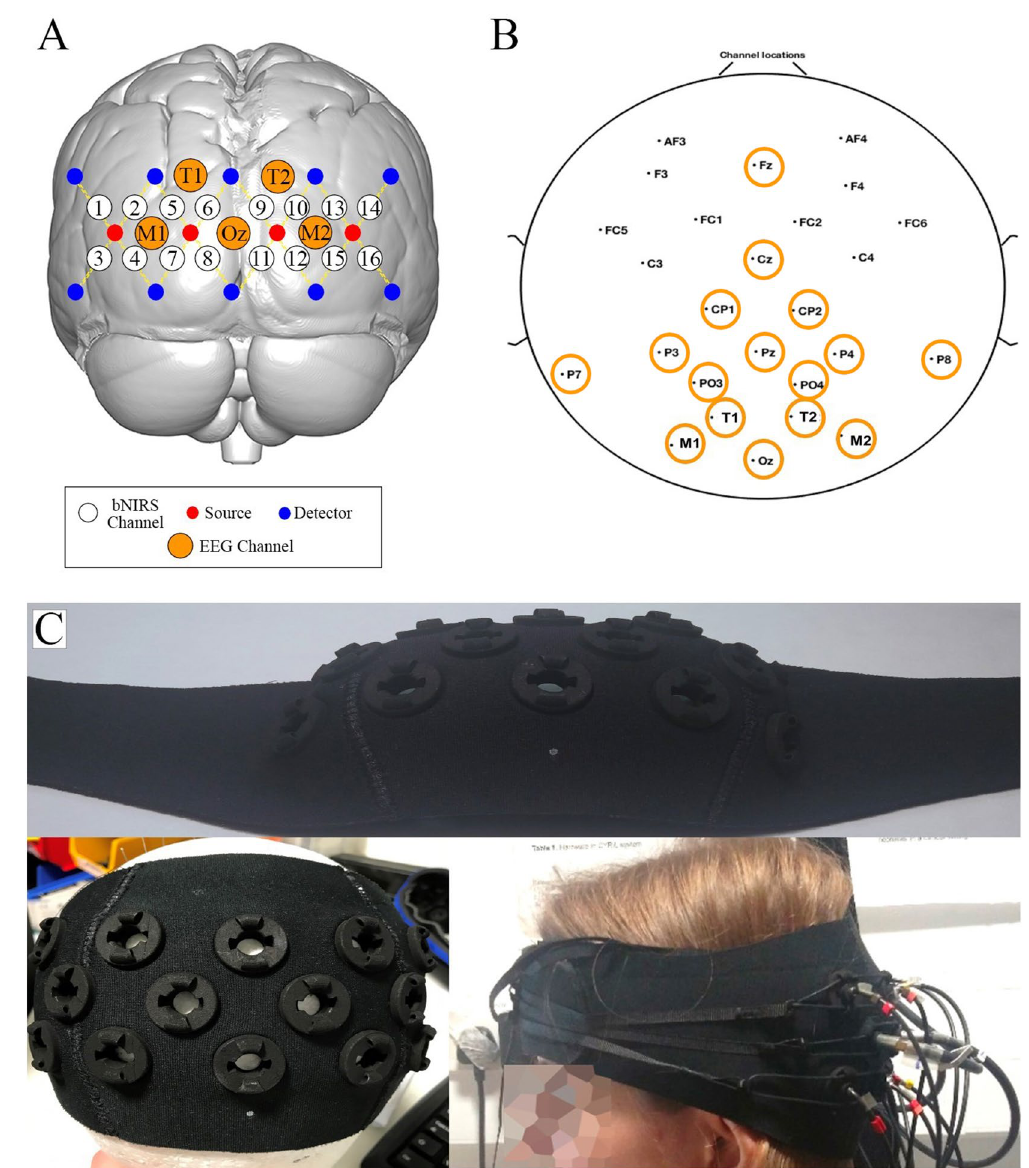
Figure 9. ( A ) Schematic representation of channel configuration over the visual cortex. Sources are represented by red circles, detectors by blue circles, and the 16 measurement channels by white circles. The EEG channels used for the combined bNIRS-EEG analysis are shown in orange. ( B ) Locations of the 26 EEG electrodes. The electrodes used for the combined bNIRS – EEG analysis are circled in orange. ( C ) Picture of the bNIRS probe holder. It is made of 3D printed optode holders and a neoprene band moulded to follow the curvature of the participants’